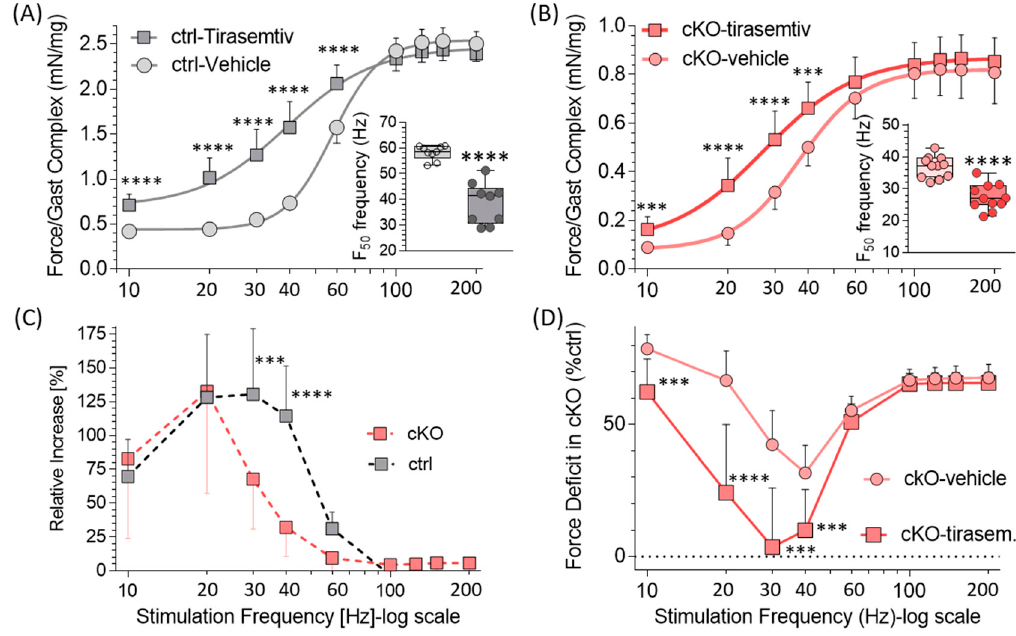
Figure 5. Force–frequency relation of in vivo gastrocnemius muscle complex measured in vehicle or tirasemtiv in ctrl and Neb cKO mice. ( A and B ) Force in tirasemtiv (square) and in vehicle (circle) in ctrl (A) and cKO (B) mice. Two-way ANOVA with repeated measures reveals in both genotypes that tirasemtiv significantly ( p < 0.0001) affects force in ctrl ( A ) and cKO ( B ) mice. Post-hoc tests (Sidak) corrected for multiple comparisons reveal that tirasemtiv increases force at low–intermediate frequencies. Insets show frequency that results in half-maximal force, F 50 frequency (light color: vehicle, dark color- tirasemtiv ). An unpaired two-tailed t-test reveals in both genotypes a significant reduction in F50. ( C ) Effect of tirasemtiv on force over vehicle at various stimulation frequencies. In both ctrl and cKO, tirasemtiv increases force with a maximal effect at ~20 Hz. A standard